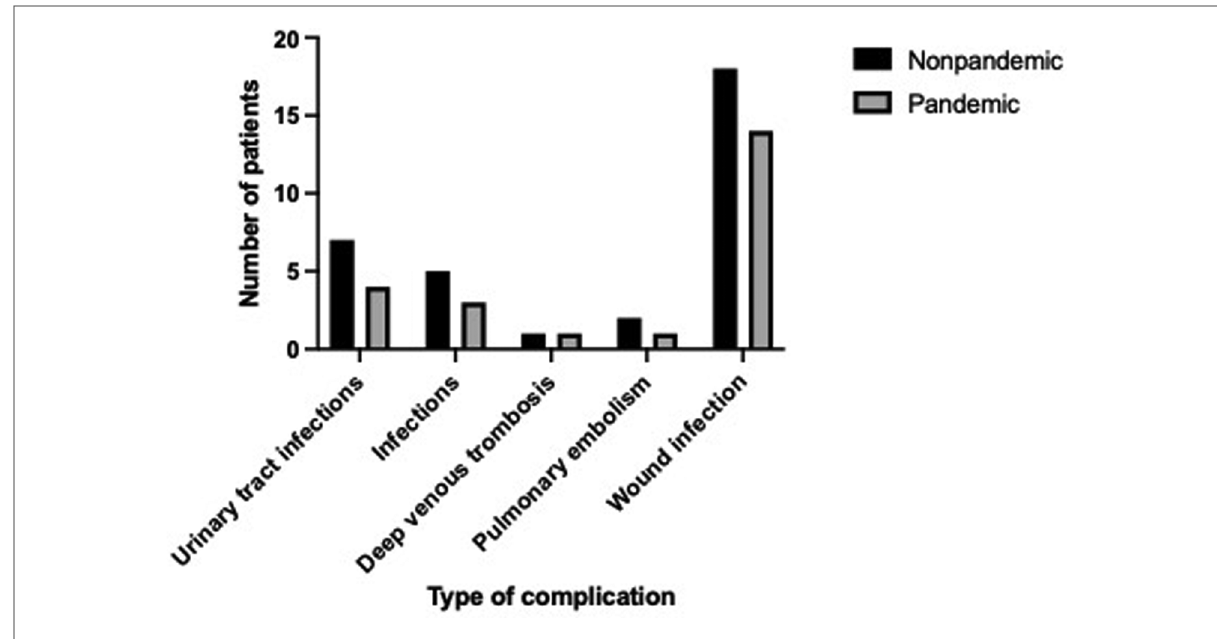
FIGURE 3 Distribution of postoperative complications.